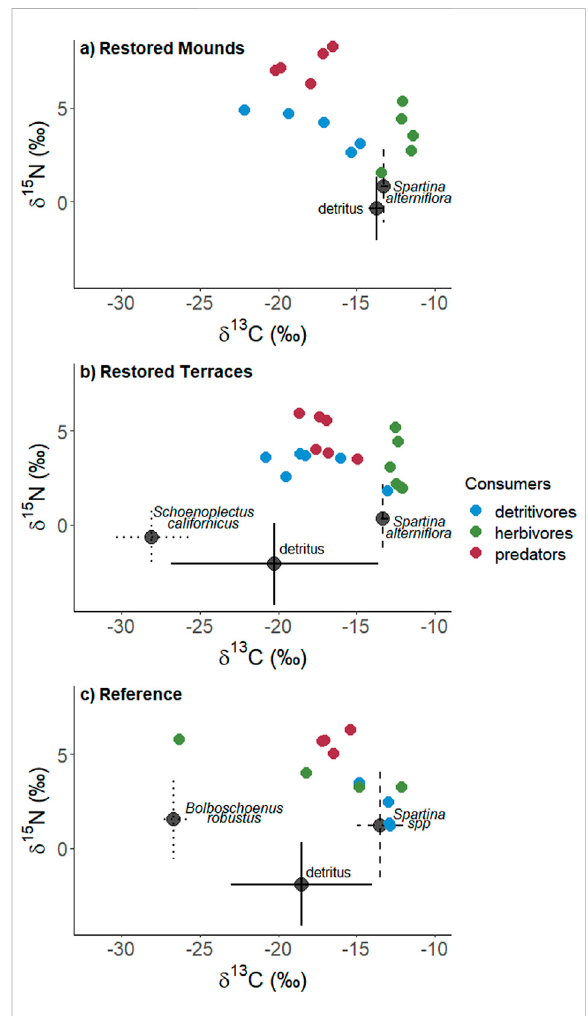
FIGURE 4 Dual isotope graphs of consumers and food sources in (A) restored mounds, (B) restored terraces, and (C) reference sites. Error bars depict standard deviation.